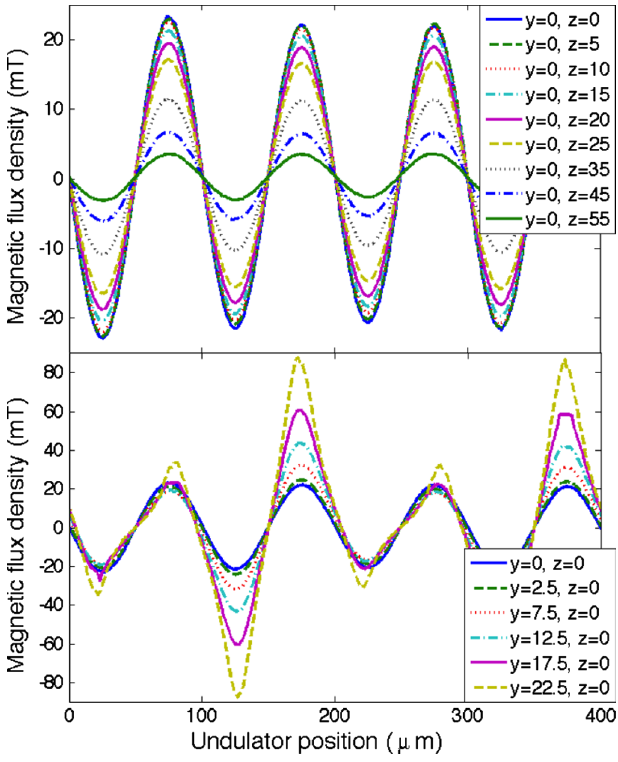
FIG. 10. Transverse magnetic flux density at different ¼ 100 (cid:1) m and g ¼ 50 (cid:1) m . The positions for Design 2 with (cid:2) u plot spans 5 of 7 periods of an undulator with y ¼ z ¼ 0 (cid:1) m at the